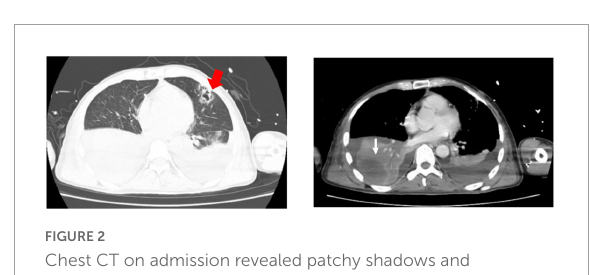
FIGURE2 Chest CT on admission revealed patchy shadows and consolidations in both lungs and pleural effusion bilaterally. Presumed abscess in the right lower lobe (white fine arrow) and cavitation in the left upper lobe (red thick arrow) were